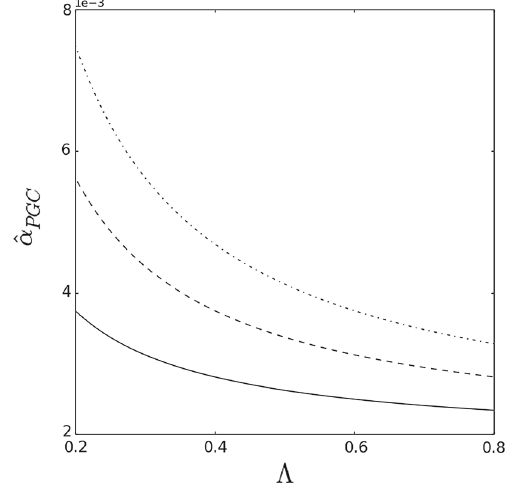
Fig. 12 Plot of ˆ α PGC vs. Λ for (cid:22) J r = 0 . 1 (continuous line), (cid:22) J r = 0 . 2 (dashed line), and (cid:22) J r = 0 . 3 (dot-dashed line). We used r 0 = 10, /ω 2 = 0 . 5. Note the scale used sin χ = 1, s = 0 . 03, b = 100 and ω 2 f for the deflection angle: each value is multiplied by 1 e − 3 = 1 × 10 −